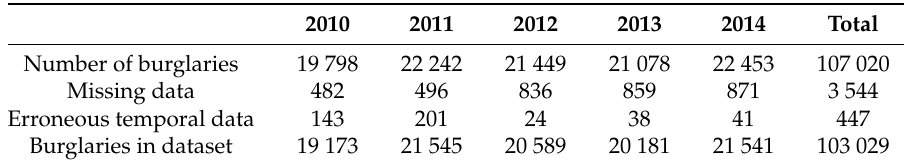
Table 1. Number of burglaries per year included in this study and the number of removed records per